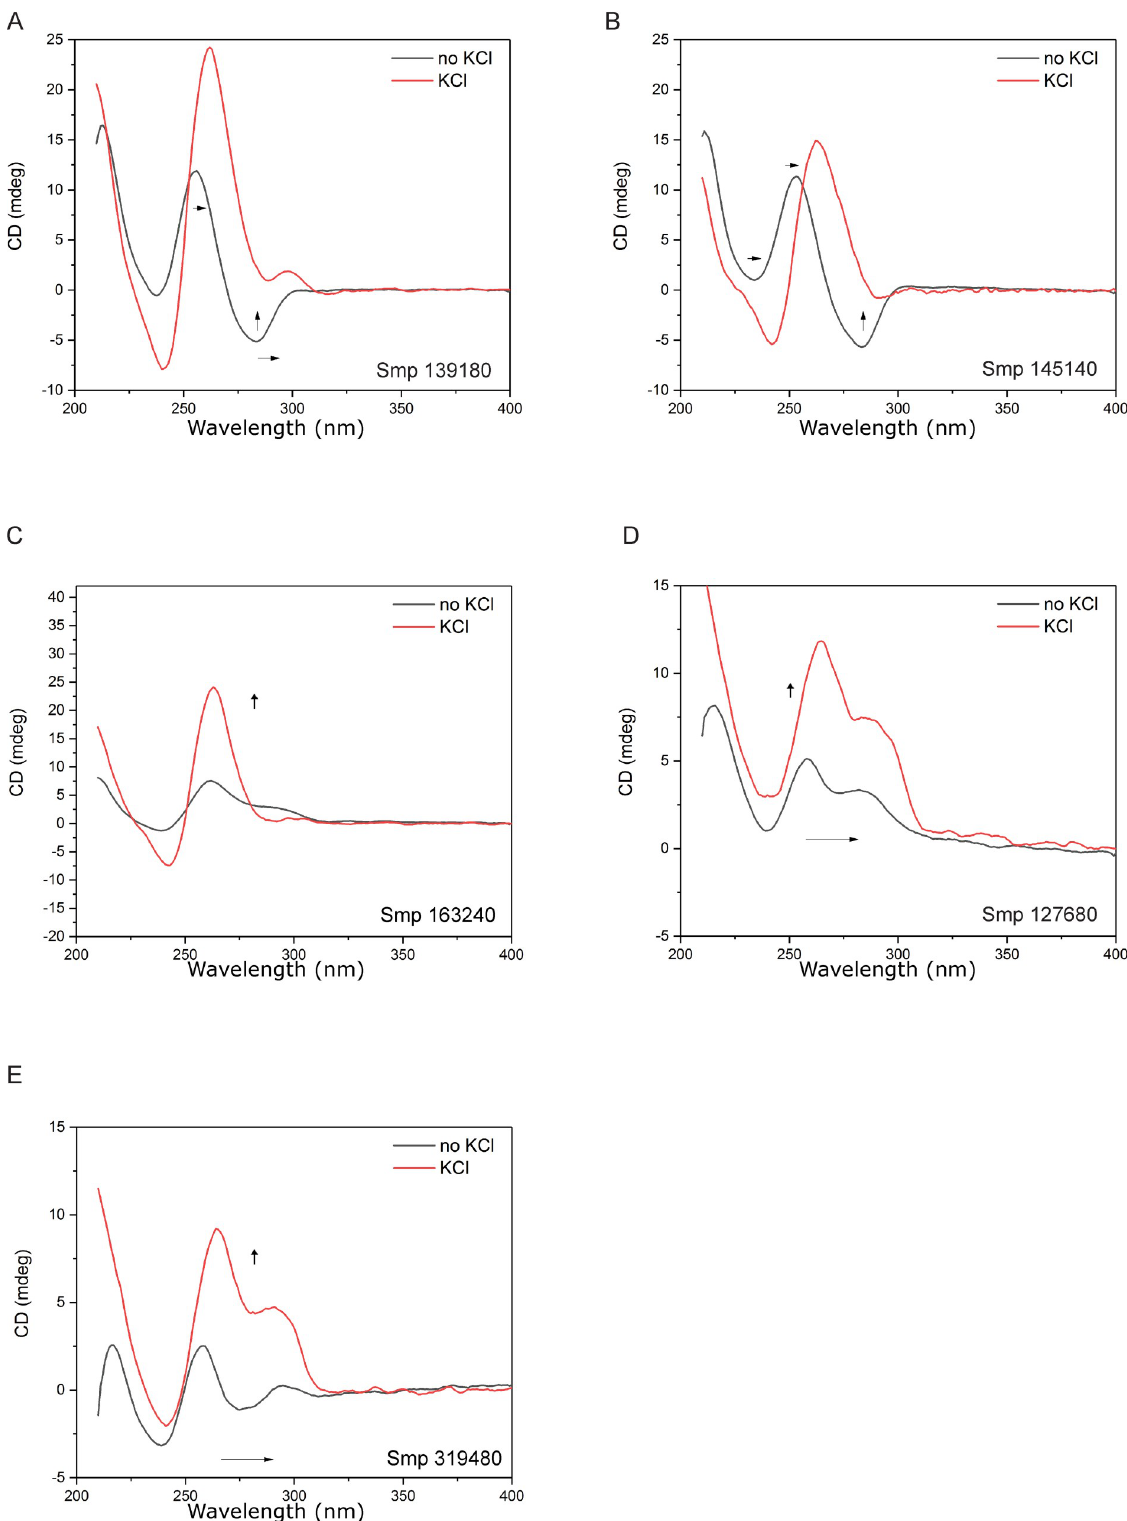
Fig 5. G4 stability of PQS-containing oligonucleotides is dependent on K + . PQS containing oligos were annealed in the presence (red line) or absence (black line) of K + ions and spectra recorded for A) smp_139180 B) smp_145140 C) smp_163240 D) smp_127680 and